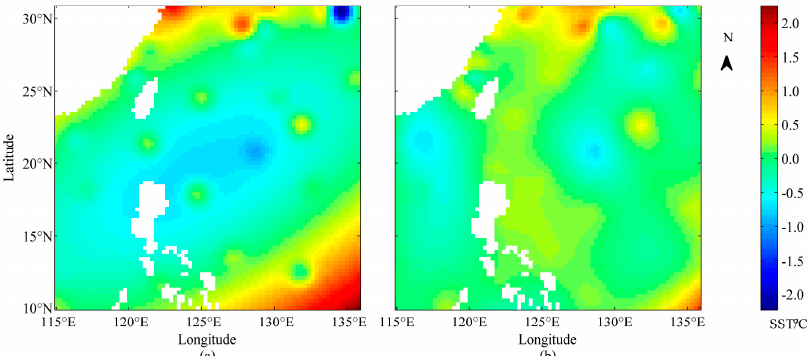
Figure 3. Reconstructed SST increments on 13 June 2014 obtained by using ( a ) Gaussian function and ( b ) multi-quadric function. White areas are lands in the images.